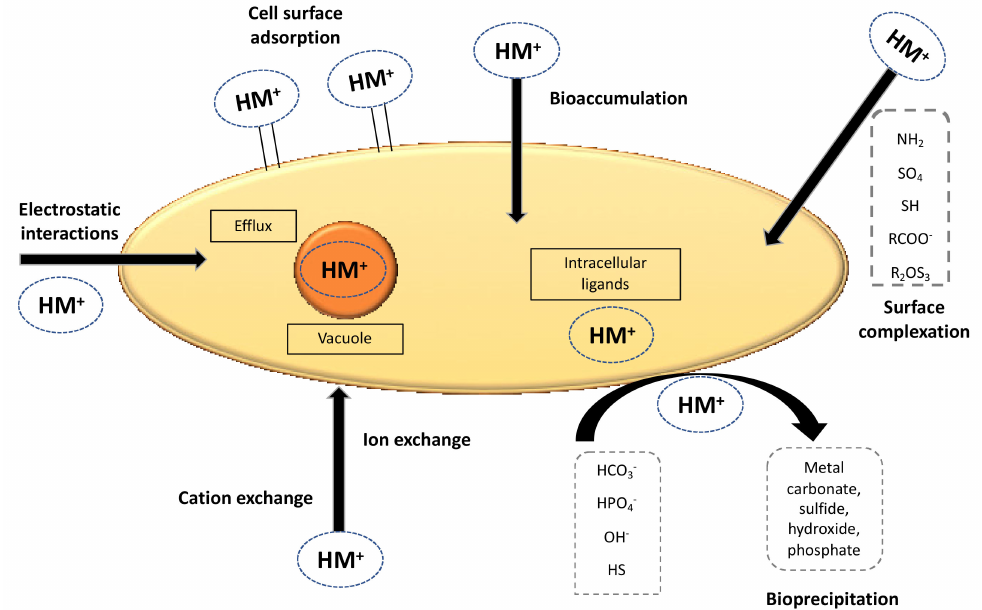
Figure 6. HMs removal strategy followed by microorganisms: the bioremediation mechanisms followed during the interaction between microorganism cell and